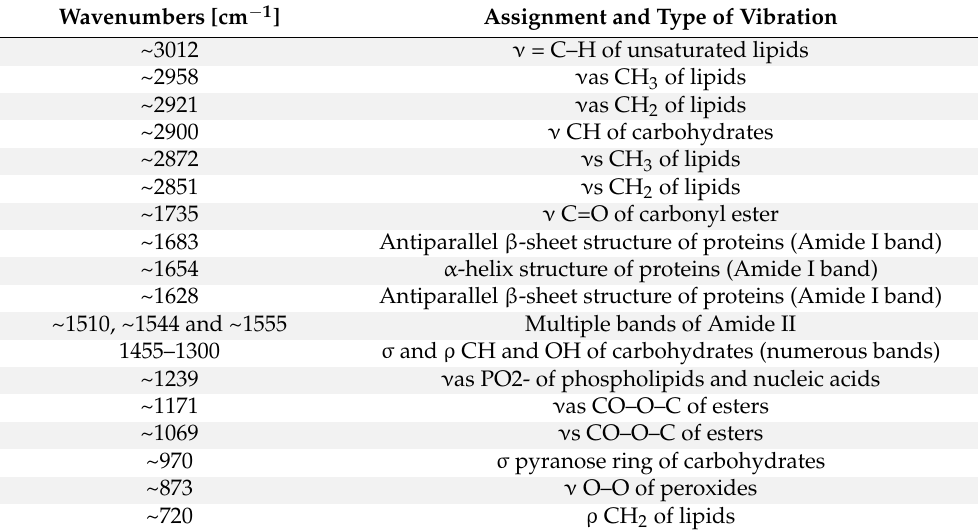
Table 1. Bands found in the mouse brain spectra with their assigned